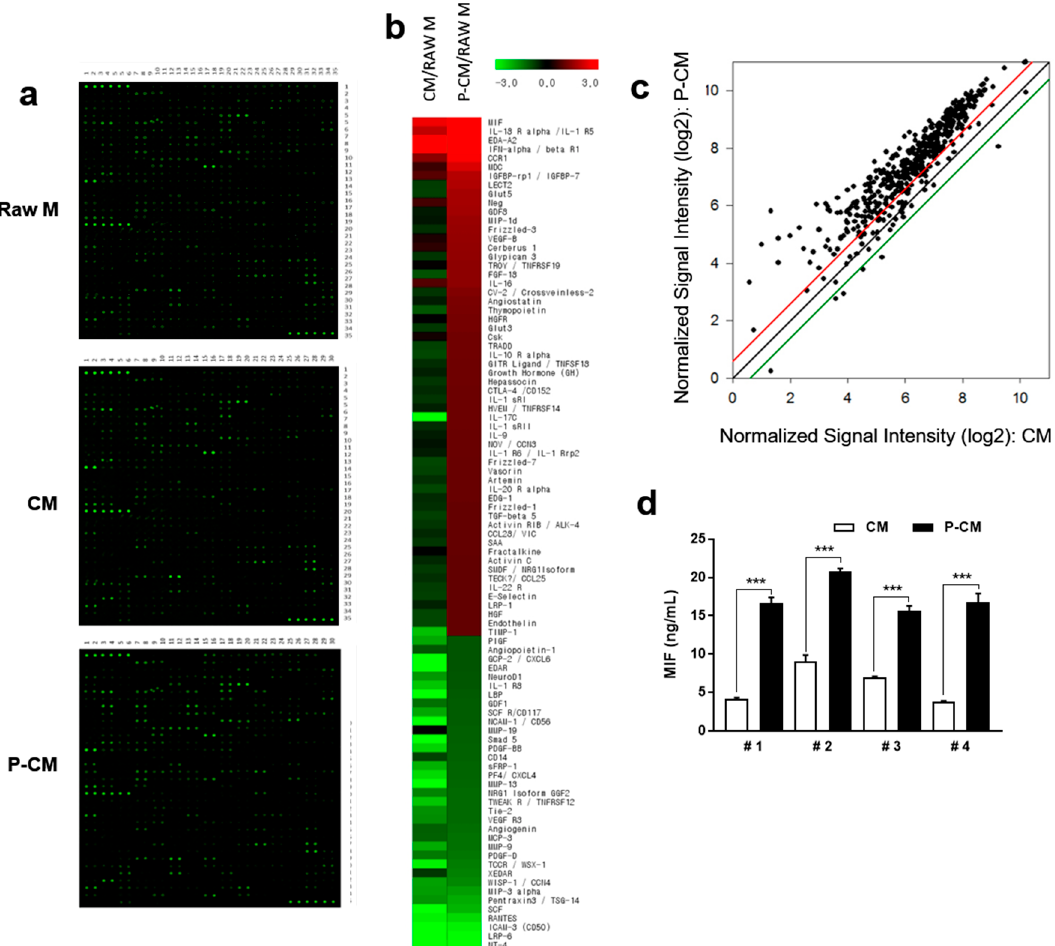
Figure 3. Priming MSCs with TGF- β 1 and LiCl resulted in a significantly increased secretion of MIF. ( a , b ) CM and P-CM, collected from supernatants of MSCs after priming with or without TGF- β 1 and LiCl, were subjected to an antibody array, and the dot intensity was then analyzed. The normalized log2 expression of cytokines, chemokines, and proteins in P-CM showed significant di ff erences ( p < 0.05) between the CM and P-CM groups, which is represented by the color scale. MIF levels in MSCs with priming were significantly increased. ( c ) After being normalized to Raw M, the normalized intensities of CM and P-CM were the logarithm to base 2 for comparison. Detailed increases (1.5-fold, red line) and decreases (1.5-fold, green line) of P-CM compared to CM are shown. ( d ) The secretion of MIF was measured by ELISA in four lots of UCB-MSCs after priming with TGF- β 1 and LiCl. Data represent the mean ± SD. ELISA was repeated four times in triplicate. The growth factor array was repeated two times. Statistically significant di ff erences were determined by one-way nonparametric ANOVA. *** p < 0.001. Abbreviations: MSC, mesenchymal stromal cells; MIF, macrophage migration inhibitory factor; CM, MSC-derived conditioned medium; P-CM, primed MSC-derived conditioned medium; Raw M, raw medium; UCB, umbilical cord